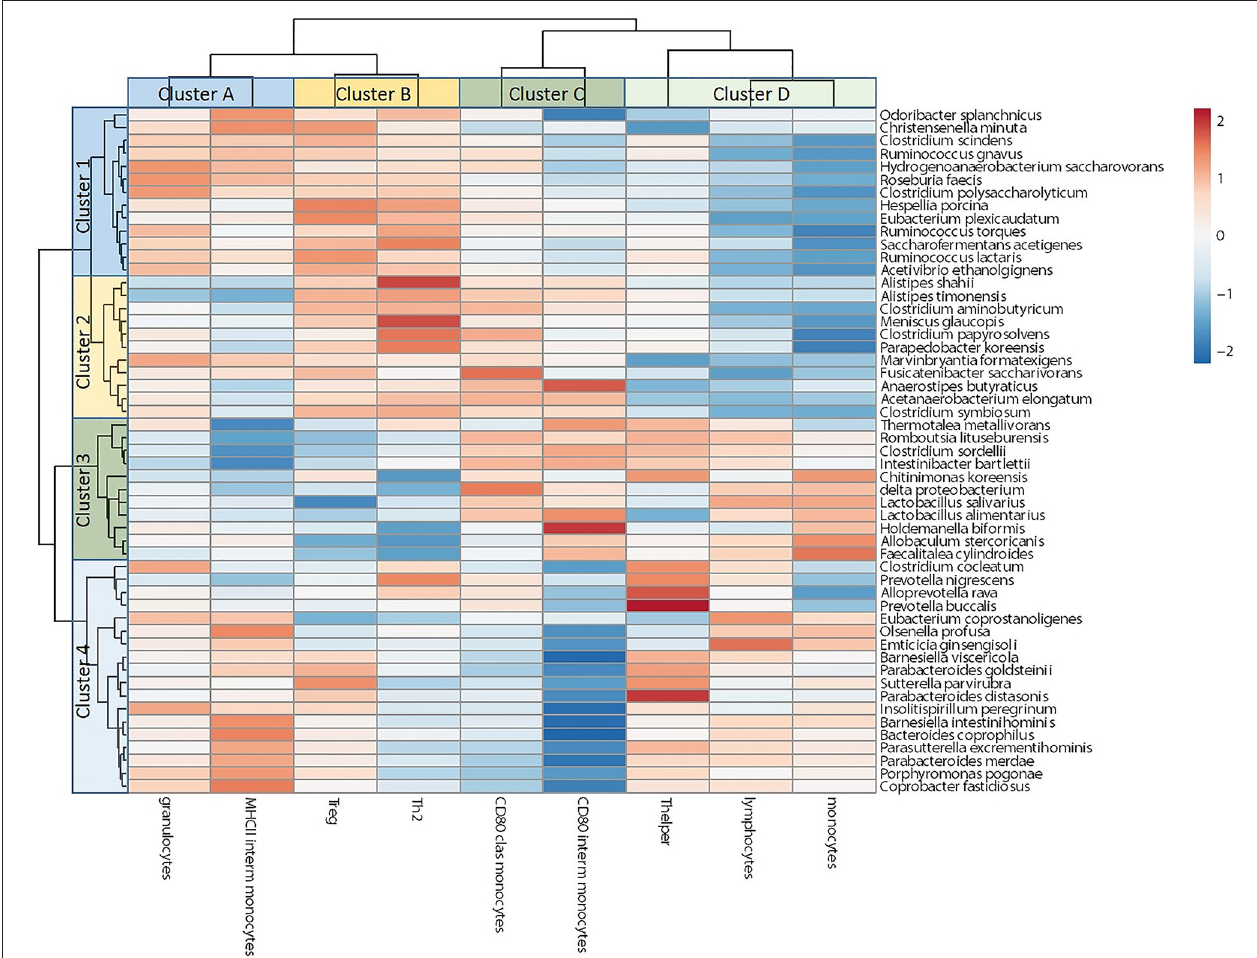
FIGURE 9 | Correlation between microbiota species and immune cell populations in conventional pregnant mice. The figure shows a heatmap of Spearman’s correlations coefficients after individual correlation of significantly different microbiota species between day 18 of pregnancy and pre-pregnancy (clusters 1–4) and immune cell populations with different adaptations in conventional vs. germfree mice (clusters